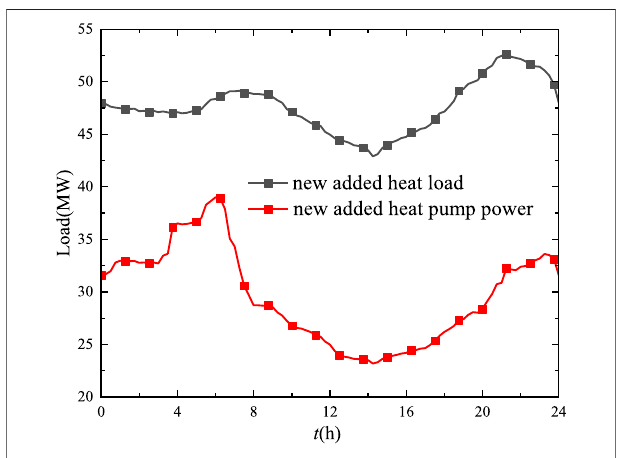
FIGURE 7 | Fluctuation curve of the newly added heat load and the corresponding electric power after introducing the electric heat pump.